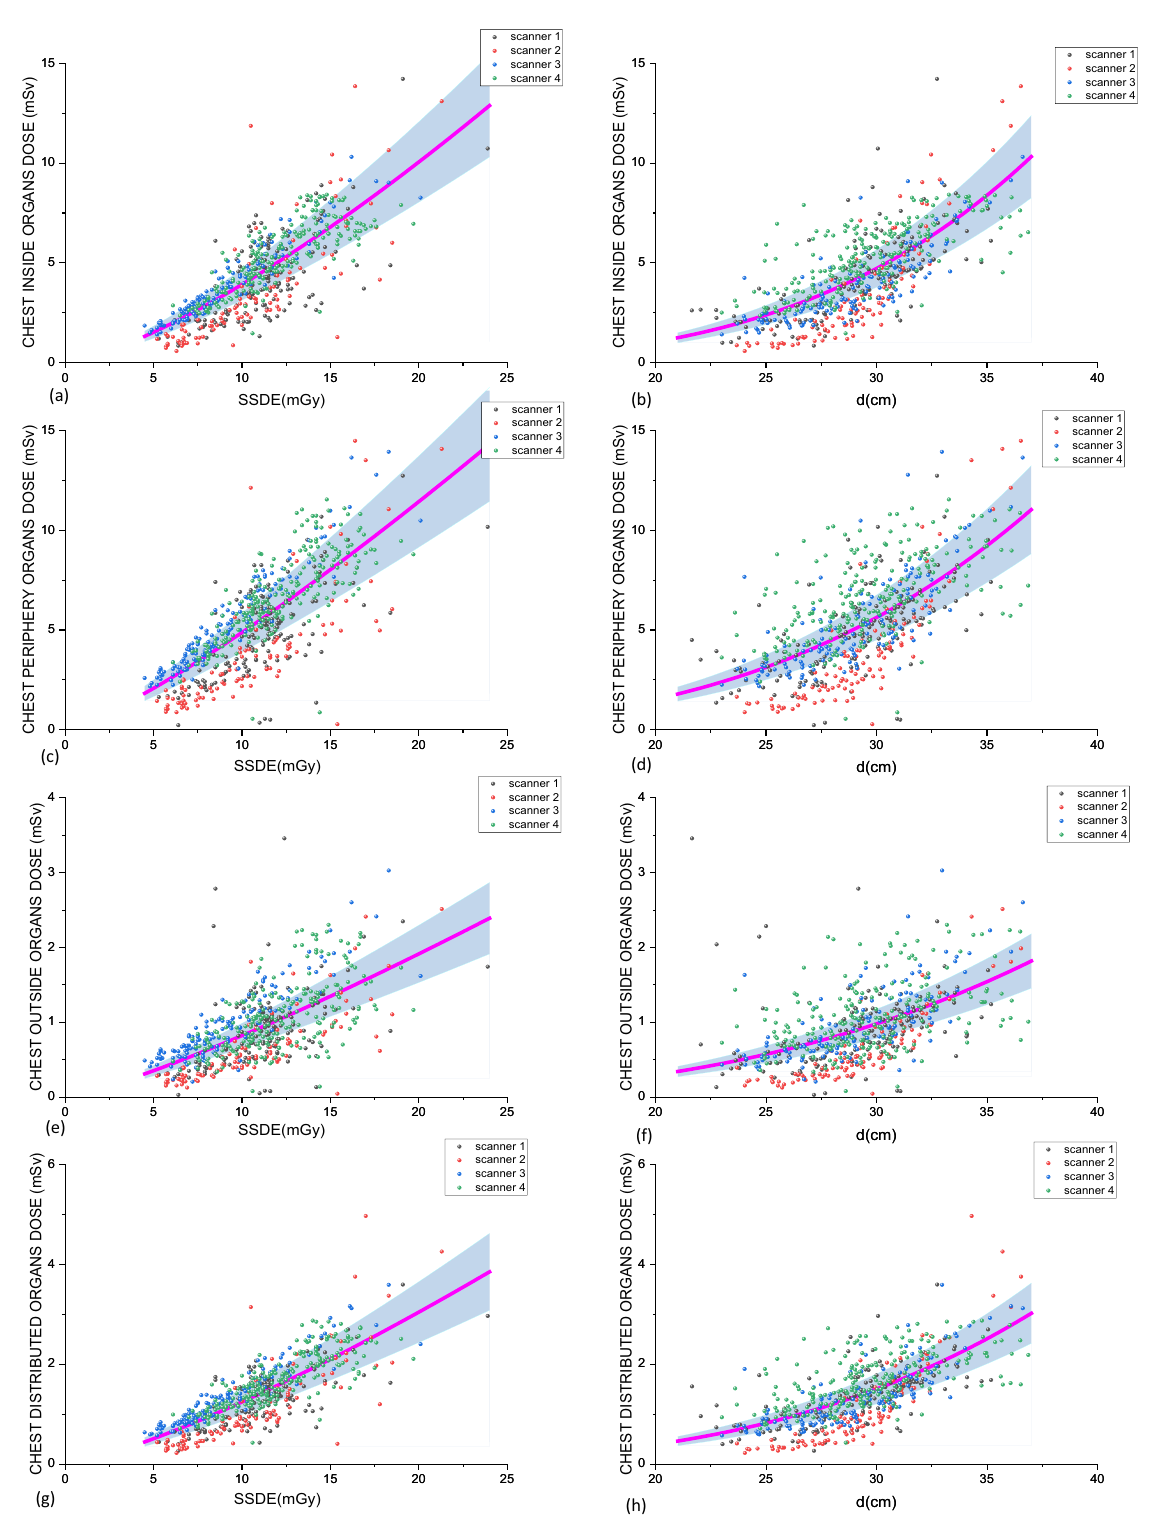
Fig. 4 Chest organ dose groups as functions of the SSDE (( a ) Inside, ( c ) Periphery, ( e ) Outside and ( g ) Distributed) and d (( b ) Inside, ( d ) Periphery, ( f ) Outside and ( h ) Distributed). The magenta lines correspond to the fittings using Eq. 2 considering the contributions of patients imaged in all CT scanners. The blue band refers to a range of 20% around this average line. The dots identify each CT scanner used in the ±